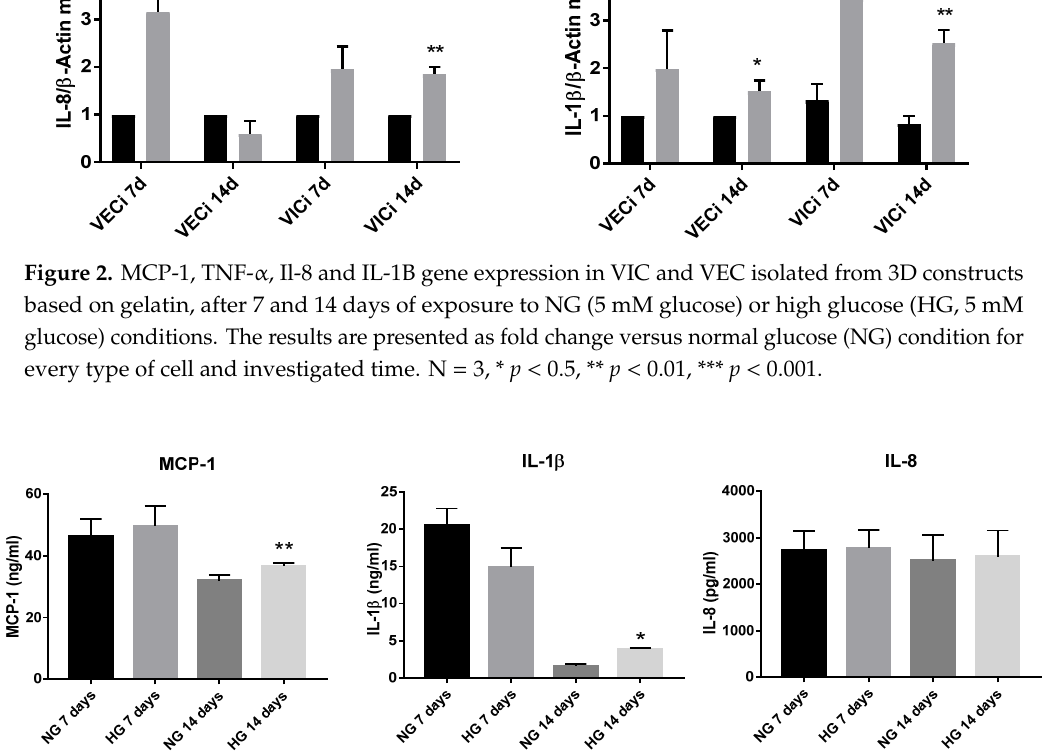
Figure 2. MCP-1, TNF- α , Il-8 and IL-1B gene expression in VIC and VEC isolated from 3D constructs based on gelatin, after 7 and 14 days of exposure to NG (5 mM glucose) or high glucose (HG, 5 mM glucose) conditions. The results are presented as fold change versus normal glucose (NG) condition for every type of cell and investigated time. N = 3, * p < 0.5, ** p < 0.01, *** p < 0.001.